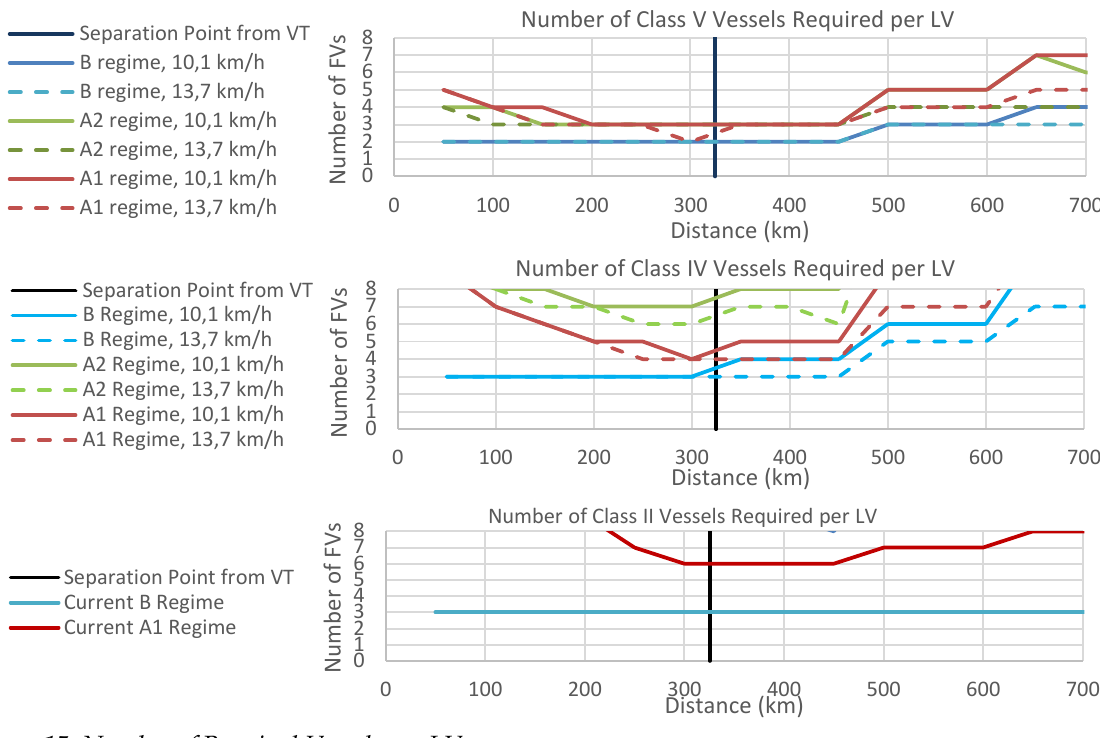
Figure 15: Number of Required Vessels per